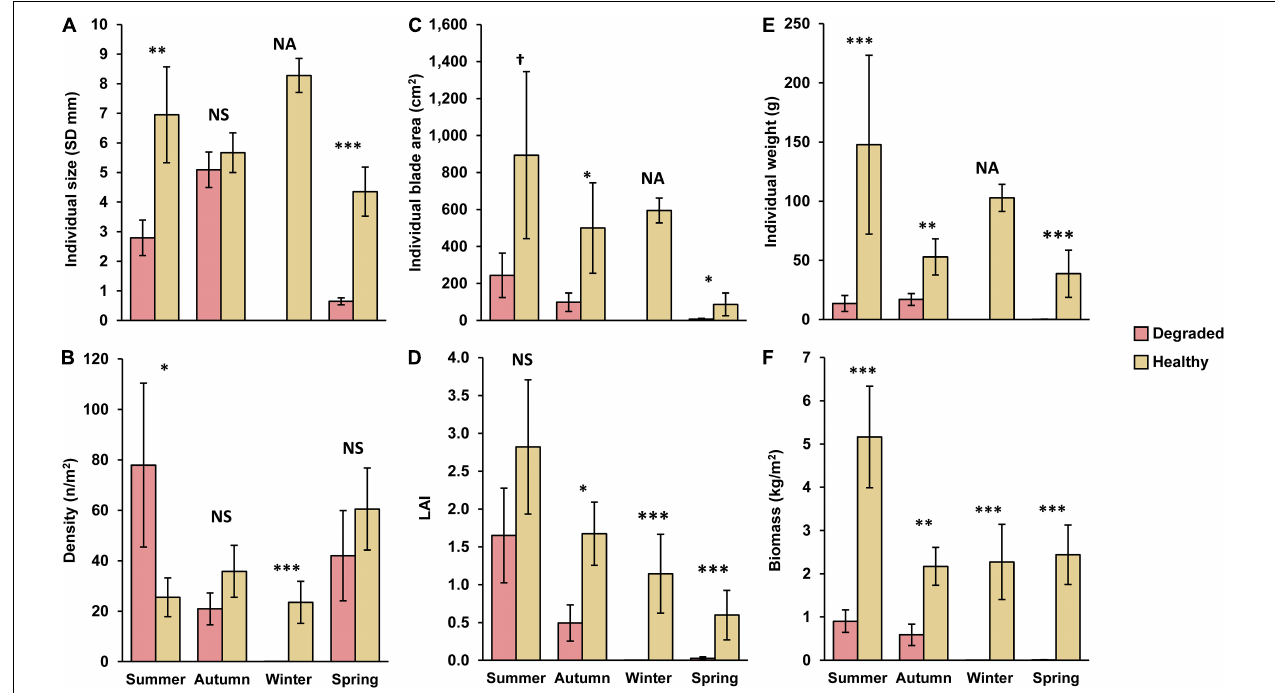
FIGURE 4 | Laminaria ochroleuca. Influence of conservation status (healthy vs. degraded golden kelp reefs) on (A,C,E) individual (size as stipe diameter SD, blade area, weight) and (B,D,F) population (density, Leaf Area Index, biomass) attributes. Values are least-squares means (and SE) from a generalized linear mixed model GLMM. df for individual-based means are 597 (summer), 313 (autumn), 154 (winter), and 562 (spring). df for population-based means are 35 (summer), 36 (autumn), 19 (winter), and 35 (spring). Significant differences between healthy and degraded kelp reefs are shown for each season based on Wald χ 2 tests of conservation Status as fixed term fitted in a GLMM with Site (all variables) and sampling Quadrat (individual-based variables only) as random effects. † P < 0.1; ∗ P < 0.5; ∗∗ P < 0.01; ∗∗∗ P < 0.001. NS = non-significant. NA = GLMM not applicable to winter populations because no viable plant was found on degraded reefs. A detailed summary of each GLMM can be found in the Supplementary Material